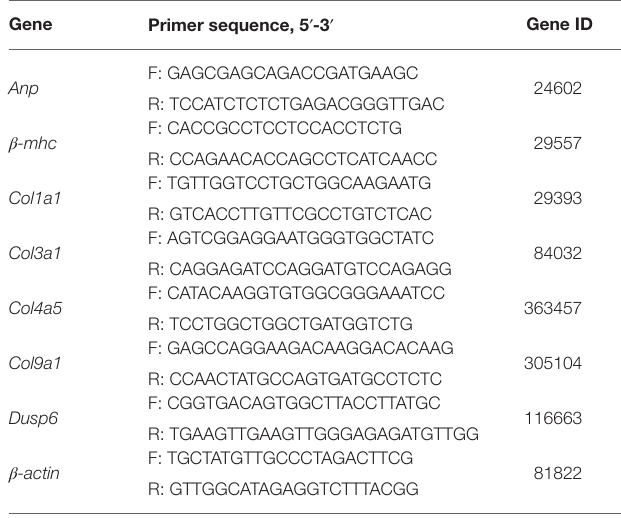
TABLE 1 | Specific sequences of primers used in real-time